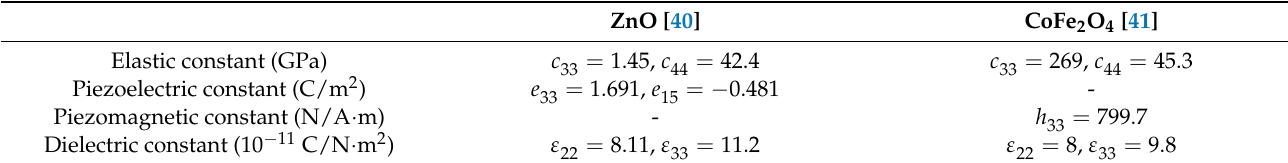
Table 1. Material constants of ZnO and CoFe 2 O